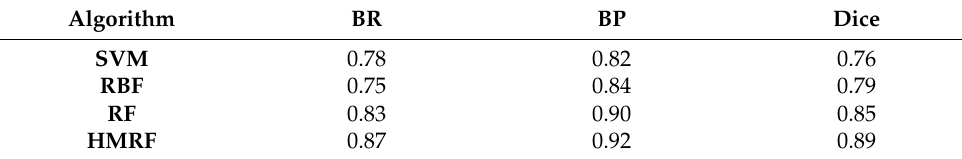
Table 2. The performance comparison of common algorithms on KITTI dataset.